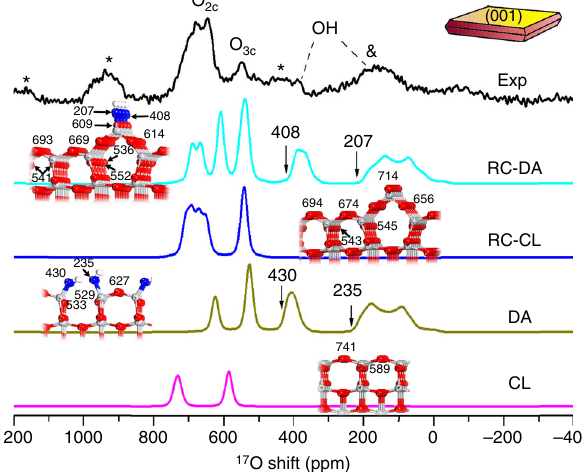
Fig. 2 Experimental and simulated 17 O NMR spectra of NS001-TiO 2 . NS001-TiO 2 (Exp) was surface selectively 17 O-labeled and vacuum-dried for 2 h. The simulated spectra are based on DFT calculations on different structures, i.e., un-reconstructed clean anatase TiO 2 (001) (CL), hydrated anatase TiO 2 (001) at a water coverage of 1 / 2 molecular layer (DA), 1 × 4-reconstructed clean anatase TiO 2 (001) (RC-CL), and hydrated 1 × 4-reconstructed anatase TiO 2 (001) (RC-DA). Insets are models of corresponding surface structures, where gray , white , blue , and red spheres represent Ti, H, O in surface hydroxyl groups, and other O species, respectively. Full view of all four structural models, isotropic chemical shifts of each oxygen sites and their quadrupolar parameters are presented in Supplementary Figs. 15 – 18 and Supplementary Tables 5 – 8. Asterisks denote sidebands. Ampersand denotes sideband overlapping with the OH signal. The arrows show the calculated isotropic chemical shift values of